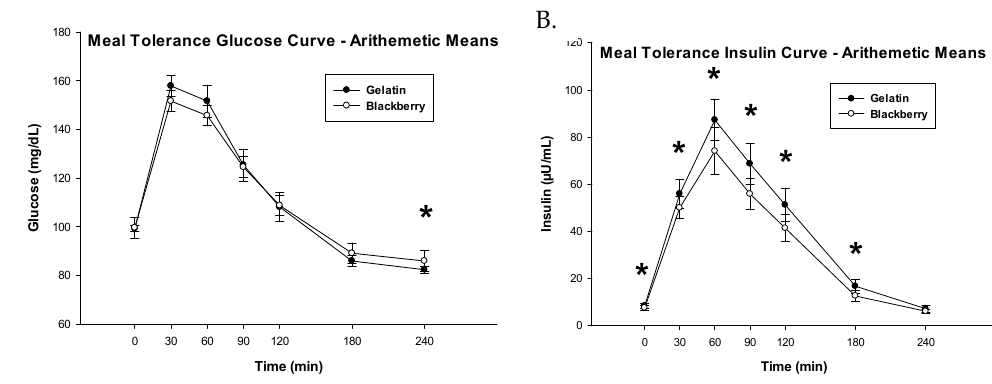
Figure 2. Interactions between treatment and BMI ( A , C ) and treatment and age ( B ) for fuel utilization for adult men consuming blackberries vs. gelatin for 7 days. n = 17 subjects. 3.3. Glucose Metabolism and Insulin Sensitivity Both the glucose and insulin curves required ln transformation prior to parametric analyses. One subject’s MTT measurements were excluded from analyses due to self-reported noncompliance. The difference between diet treatments for glucose iAUC was not significantly different (3488 vs. 4070 mg·min/dL, BB vs. GEL, respectively, p = 0.1151, Figure 3A, Table 5). However, the difference between treatments for insulin iAUC was significant, where subjects had significantly lower iAUC when fed the BB diet compared to GEL control (6485 vs. 8245 µU·min/mL, BB vs. GEL, respectively, p = 0.0002, Figure 3B, Table 5). BMI was a significant covariate ( p = 0.0002) where insulin iAUC increased with increasing BMI. Additionally, a significant sequence effect of the model indicates subjects who ate gelatin and crossed-over to the blackberry treatment had a higher insulin iAUC on average (iAUC = 9589 µU·min/mL) compared to subjects who were assigned the BB diet, then crossed-over onto the GEL treatment (iAUC = 5576 µU·min/mL), p = 0.0284. This significant term reveals that there was a potential carryover effect of BBs on insulin sensitivity. However, this effect is only present with the inclusion of two subjects with high residuals, i.e., a sequence effect was not observed and ln transformation of the dataset was not required if the two outliers were removed; with outliers